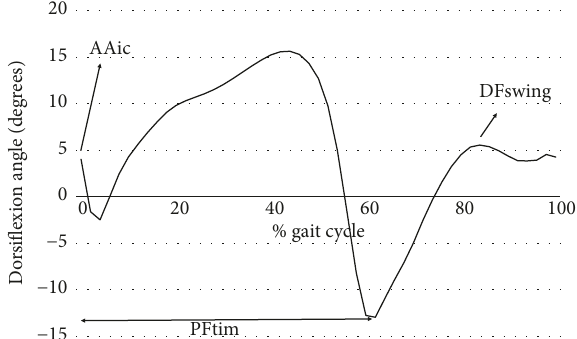
Figure 2: Typical sagittal ankle joint angle over one complete gait cycle showing the outcome measures AAIC (ankle angle at initial contact), DFswing (peak dorsiflexion in swing), and the timing of peak plantar flexion (PFtim), reported as % of gait cycle.